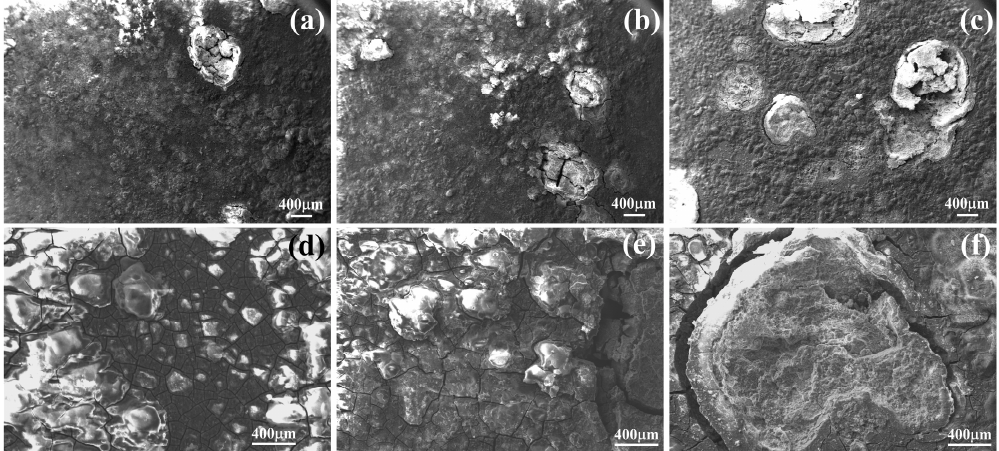
Figure 9. Corroded surface morphologies of hot-rolled Mg − xSn − 1Zn − 0.5Ca alloys after being immersed in Hank’s solution for 7 days: ( a ) Mg − 1Sn − 1Zn − 0.5Ca; ( b ) Mg − 3Sn − 1Zn − 0.5Ca; ( c ) Mg − 5Sn − 1Zn − 0.5Ca, and the corresponding magnified images ( d ), ( e ) and ( f ).